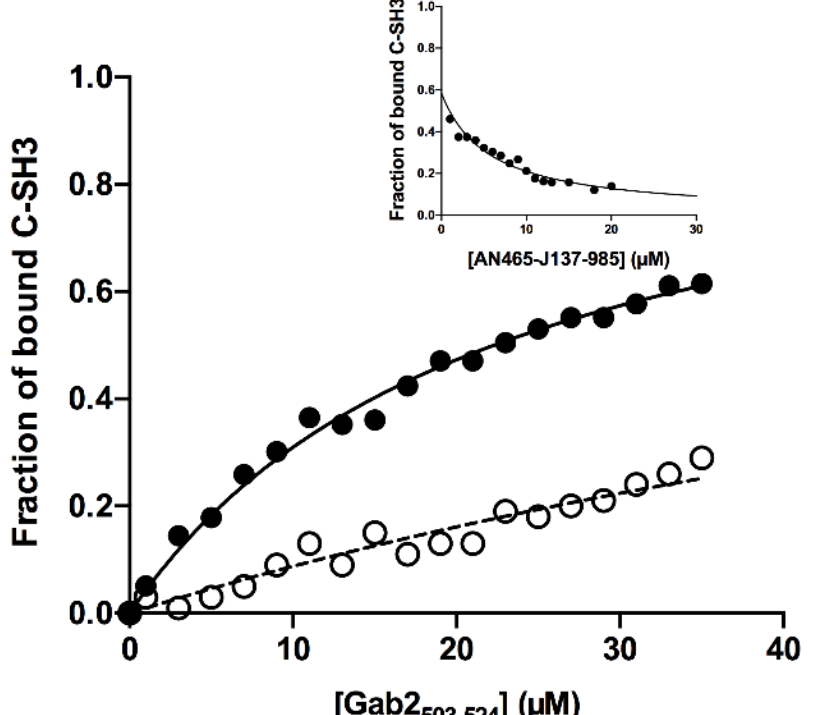
Figure 3. Equilibrium binding titration monitored by change in intrinsic fluorescence emission of C-SH3 at di ff erent concentrations of Gab2* in absence (full circles) and in presence of 5 µ M AN-465-J137-985 (empty circles). Continuous and broken lines are the best fit to a hyperbolic function. Inset panel. Titration of the complex between C-SH3 and Gab2*, a constant concentration of 1 µ M and 25 µ M respectively, with varying concentrations of AN-465-J137-985.